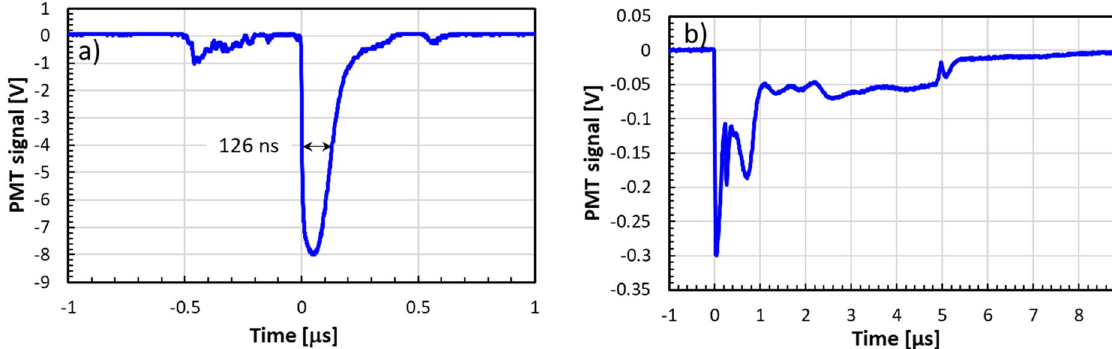
Figure 8. Oscilloscope trace of a single Clinac pulse measured directly using a scintillator and PMT tube. ( a ) FLASH mode, ( b ) SuperFLASH mode.